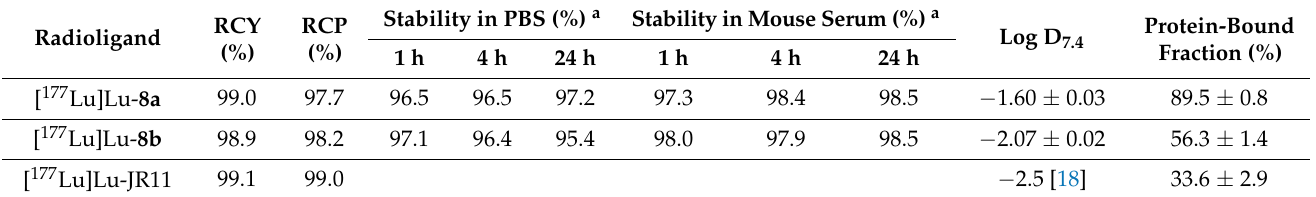
Table 1. RCY, RCP, stability in PBS ( n = 1) and mouse serum ( n = 1), LogD 7.4 ( n = 3) and percentage of protein-bound fraction ( n = 3) of [ 177 Lu]Lu- 8a and [ 177 Lu]Lu- 8b